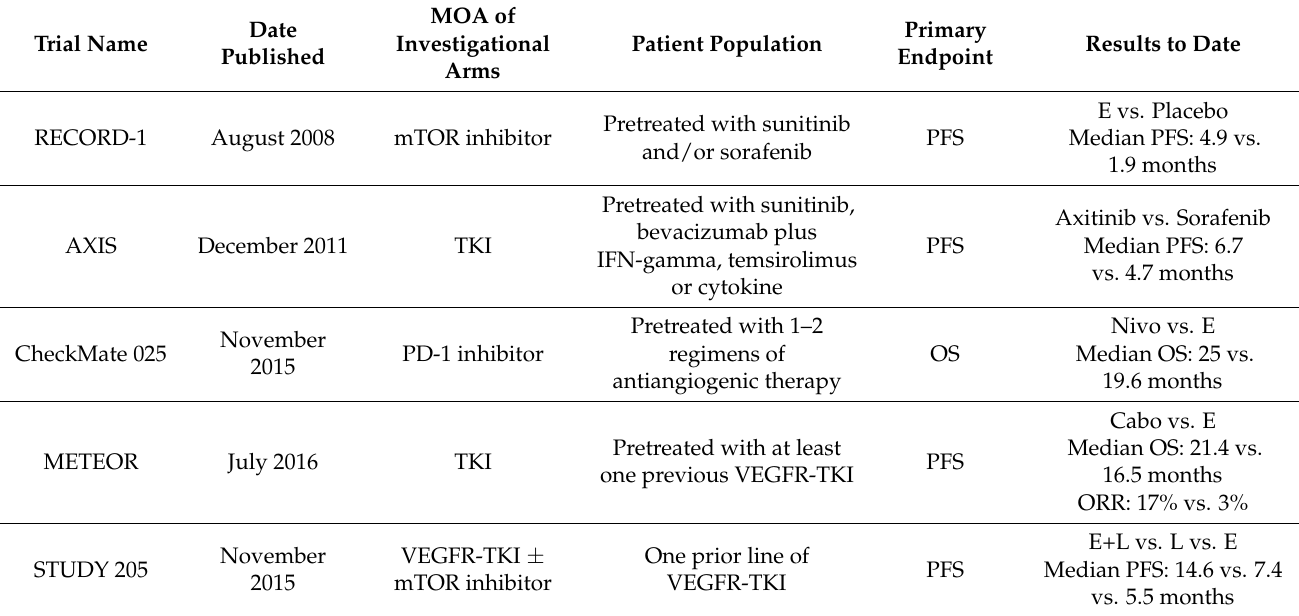
Table 3. Landmark second-line mRCC